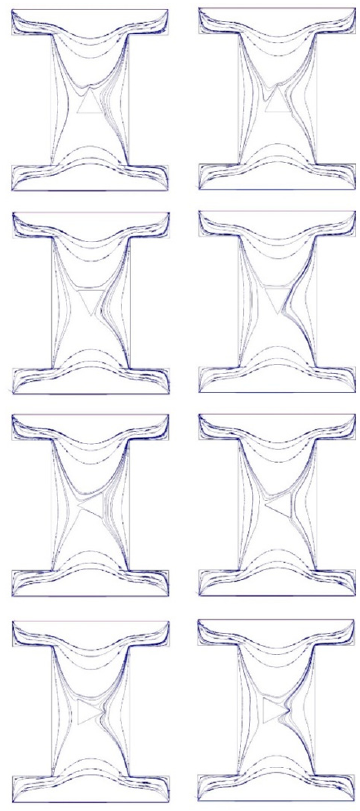
Figure 5. The streamline contours of the 4% vol. nanofluid (NF) in sand-based ( left column ) and metallic powder-based cavities ( right column ) with different orientations of the hot block .